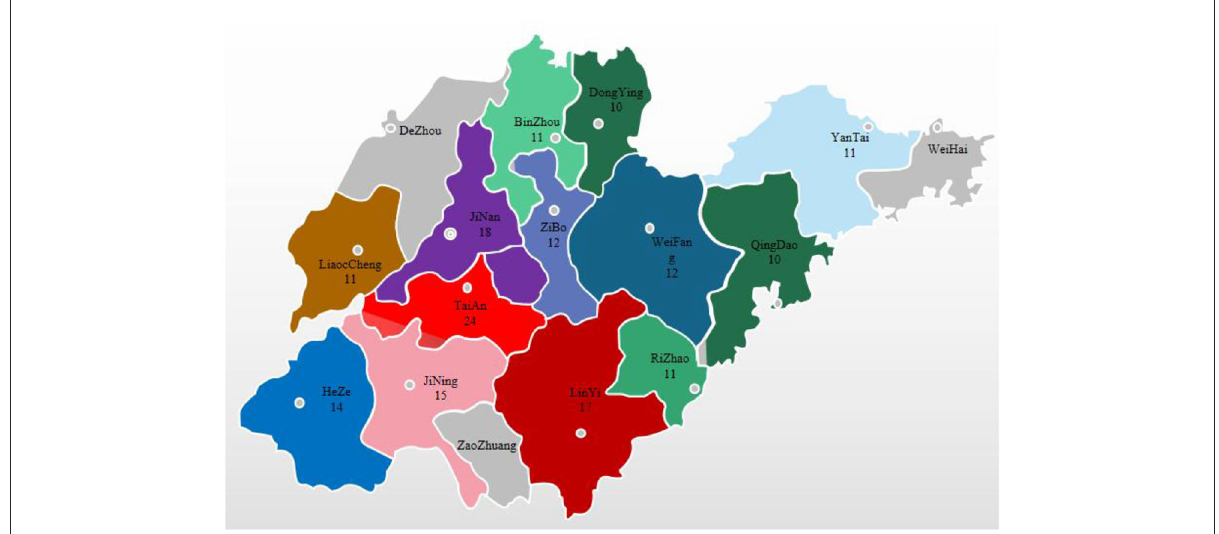
FIGURE1 Distribution of sample collection by city in Shandong Province, 2019–2021.